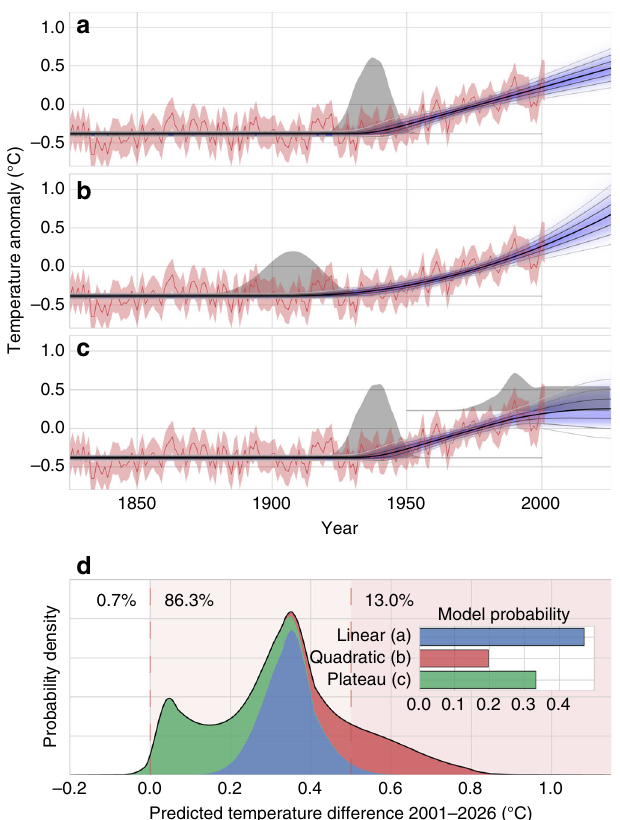
Fig. 6 Weighting different climate change scenarios. a Reconstructed annual mean temperature (red line) and corresponding standard error intervals (red shading) from the PAGES 2k Consortium for the Australasia region. Assuming a linear increase in temperature after a break-point, the distribution of the inferred temperature (blue shading), together with its mean value (black line) and 1 s.d., 2 s.d., and 3 s.d.-intervals (from dark to light gray) are displayed. The inferred distribution of the breakpoint is depicted in gray. b Same as in a , but assuming a quadratic increase in temperature after a break-point. c Same as in a , but assuming a second temperature plateau after a linear warming. d Distribution of predicted temperature differences between 2001 and 2026, obtained by averaging of single model predictions, weighted by the respective model evidence